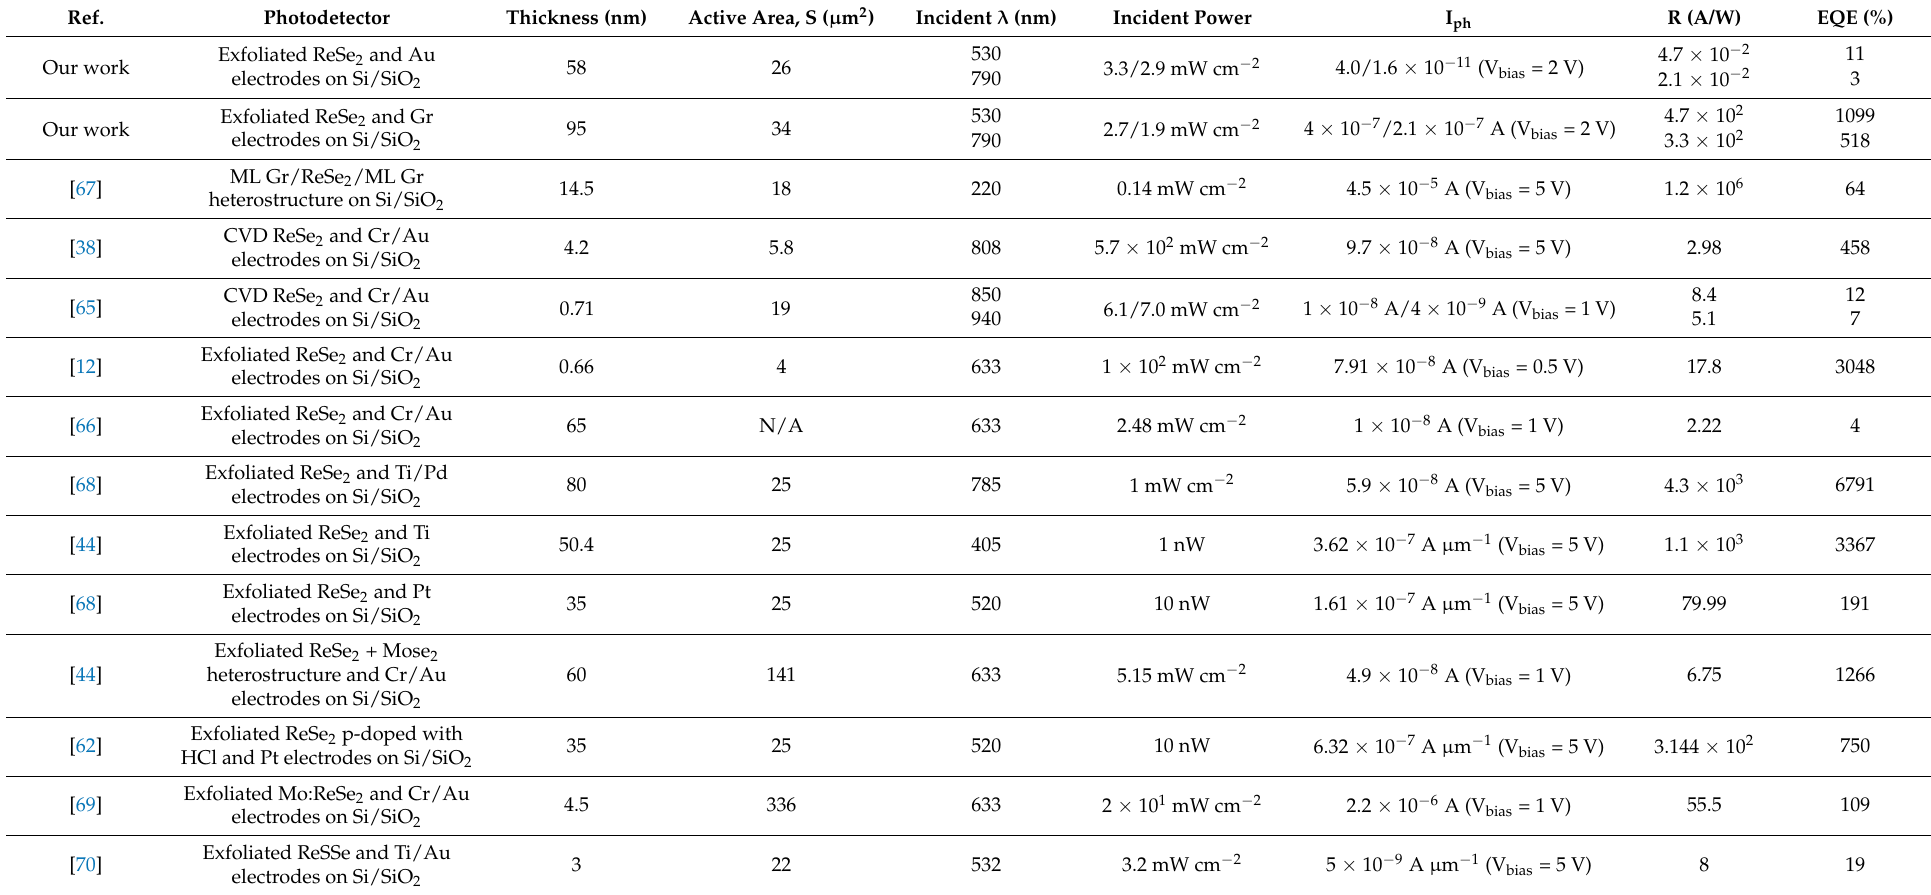
Table 2. Comparison of key parameters from our ReSe 2 +Gr device and other reported ReSe 2 based photodetectors. Ref. Exfoliated ReSe 2 and Au Our work electrodes on Si/SiO 2 Our